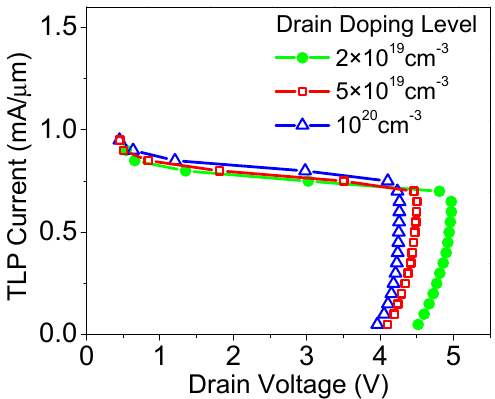
Figure 11. TLP I-V curves of SiGe S/D TFET with different Ge mole fractions.